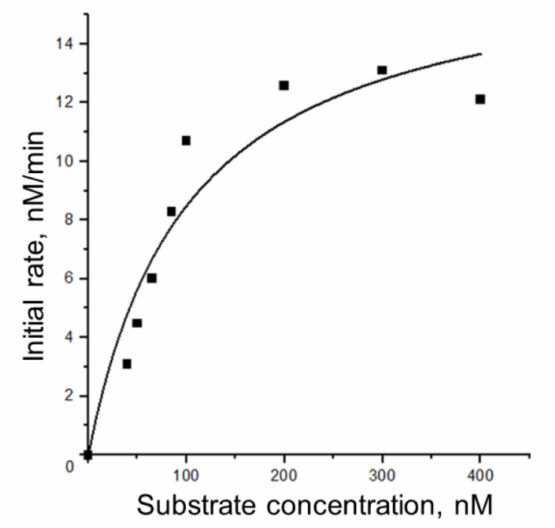
Figure 8. Dependence of the initial rate of II-19A nicking by Nt.BspD6I (7 nM) on the DNA substrate concentration. Each data point is an average from at least three independent experiments. Table 4. Kinetic parameters of the interaction of some REs with short DNA substrates in steady- state